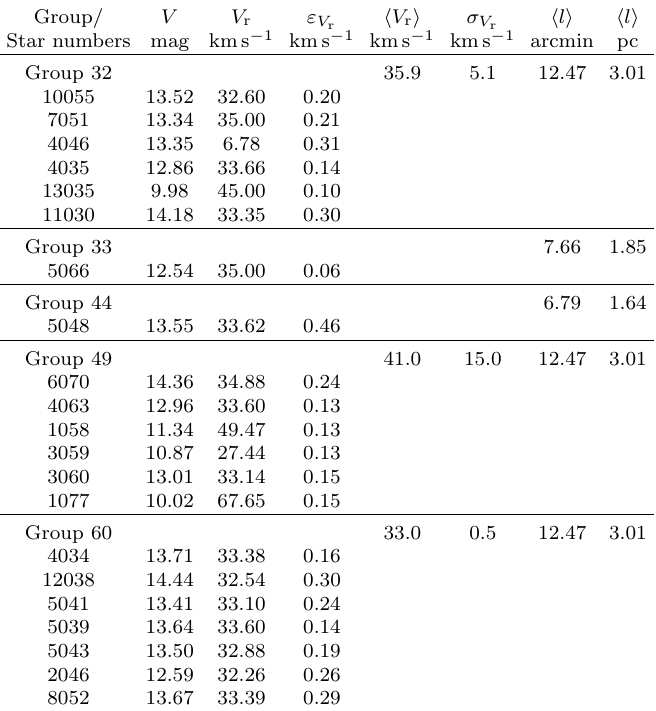
Table 1. Parameters of the star groups in M